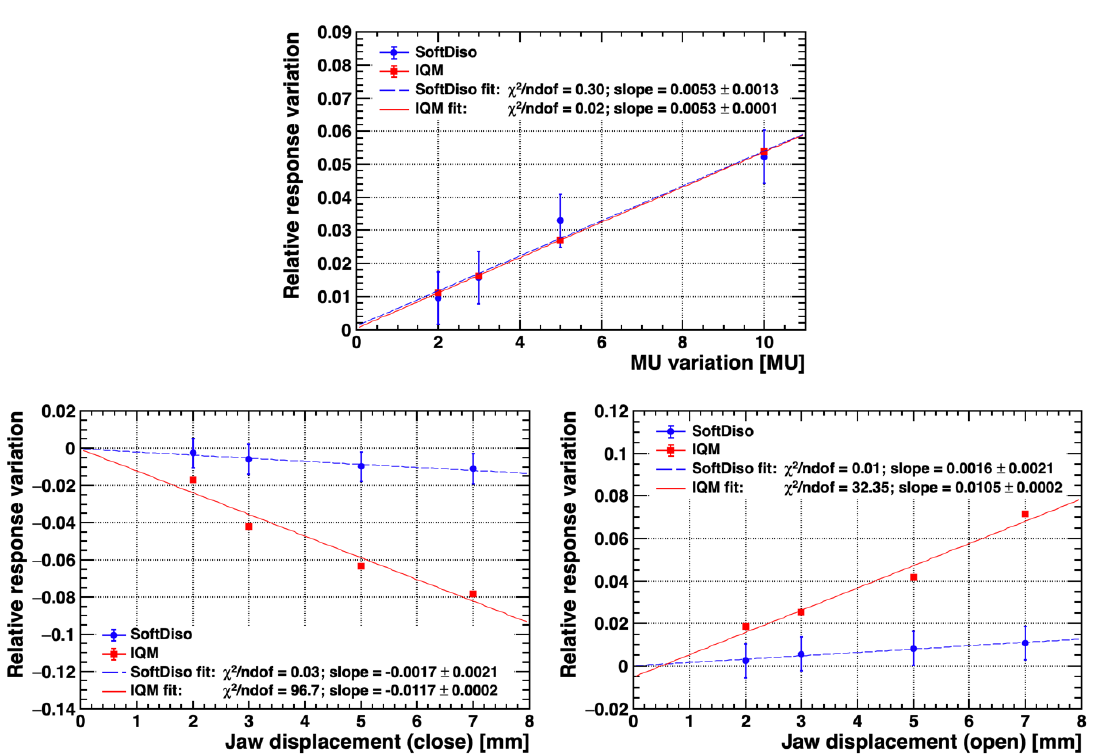
Figure 4. Deviations from reference values of IQM signal and SoftDiso R-values as functions of MU variations ( top ) and of jaw position variation in close ( bottom left ) and open ( bottom right ) directions.